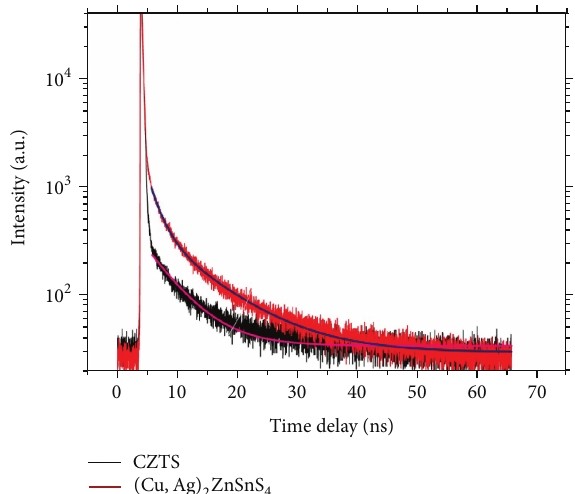
Figure 5: Time-resolved photoluminescence traces of absorbers fabricated with or without an Ag intermediate layer. The minority carrier lifetime can be obtained from curve fitting the data using equation (4). The blue and pink curves correspond to fitted ones for (Cu,Ag) 2 ZnSnS 4 and CZTS,